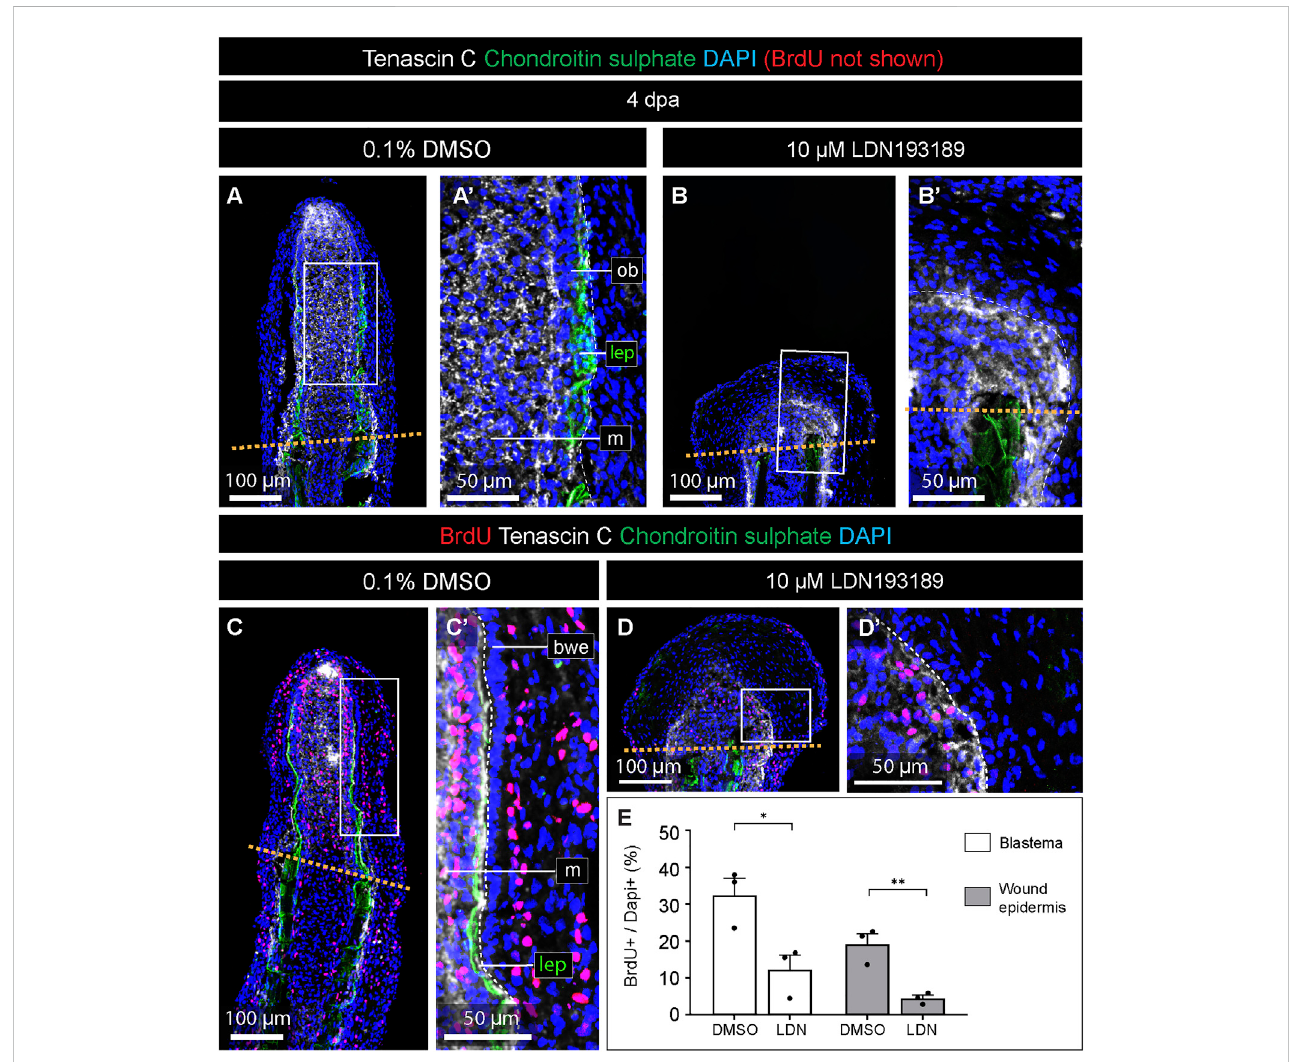
FIGURE 5 TheinhibitionofBMPsignalingimpairscellproliferationintheblastemaandthewoundepidermis. (A – D) Quadruple fl uorescencestainingof fi nsections at 4 dpa with antibodies against chondroitin sulphate (green) to visualize lepidotrichia, Tenascin C (white) to detect an extracellular protein of the blastema, BrdU (red), and DAPI (blue). Orange dashed lines depicts the amputation plane; white dashed lines underly the basal epithelium (bwe). We; wound epidermis; m; mesenchyme; lep, lepidotrichia. (E) Quanti fi cation of the proportion of nuclei labeled with BrdU in the two compartments in treated and control fi ns. N = 3, average of three sections per fi n; error bar SEM; * p < 0.05; ** p < 0.01; unpaired two-tailed Student ’ s